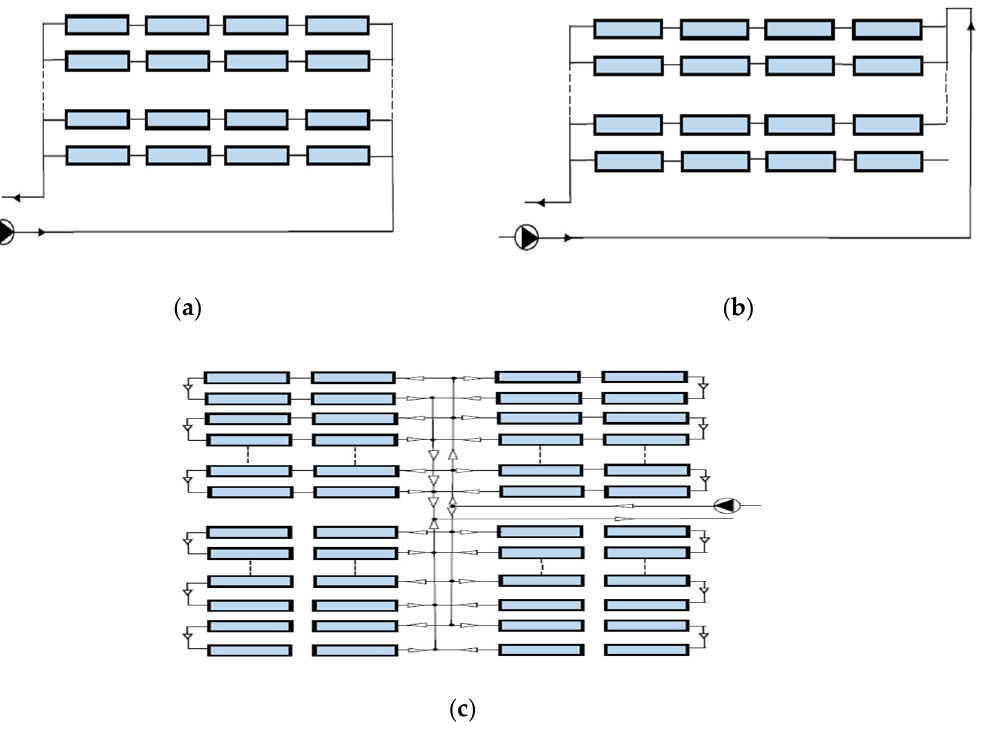
Figure 2. Piping layouts in industrial processes: ( a ) Direct Return, ( b ) Reverse Return and ( c ) Central Feed. Adapted from Ref. [35]. Copyright (2012), with permission from Elsevier.